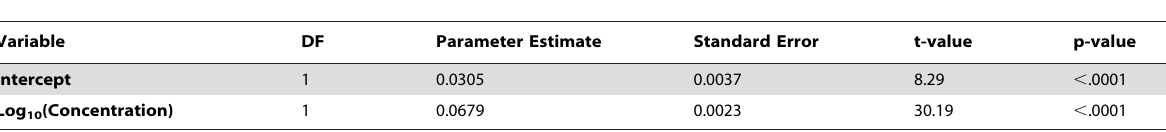
Table 3. Linear regression parameter estimates (V2R).